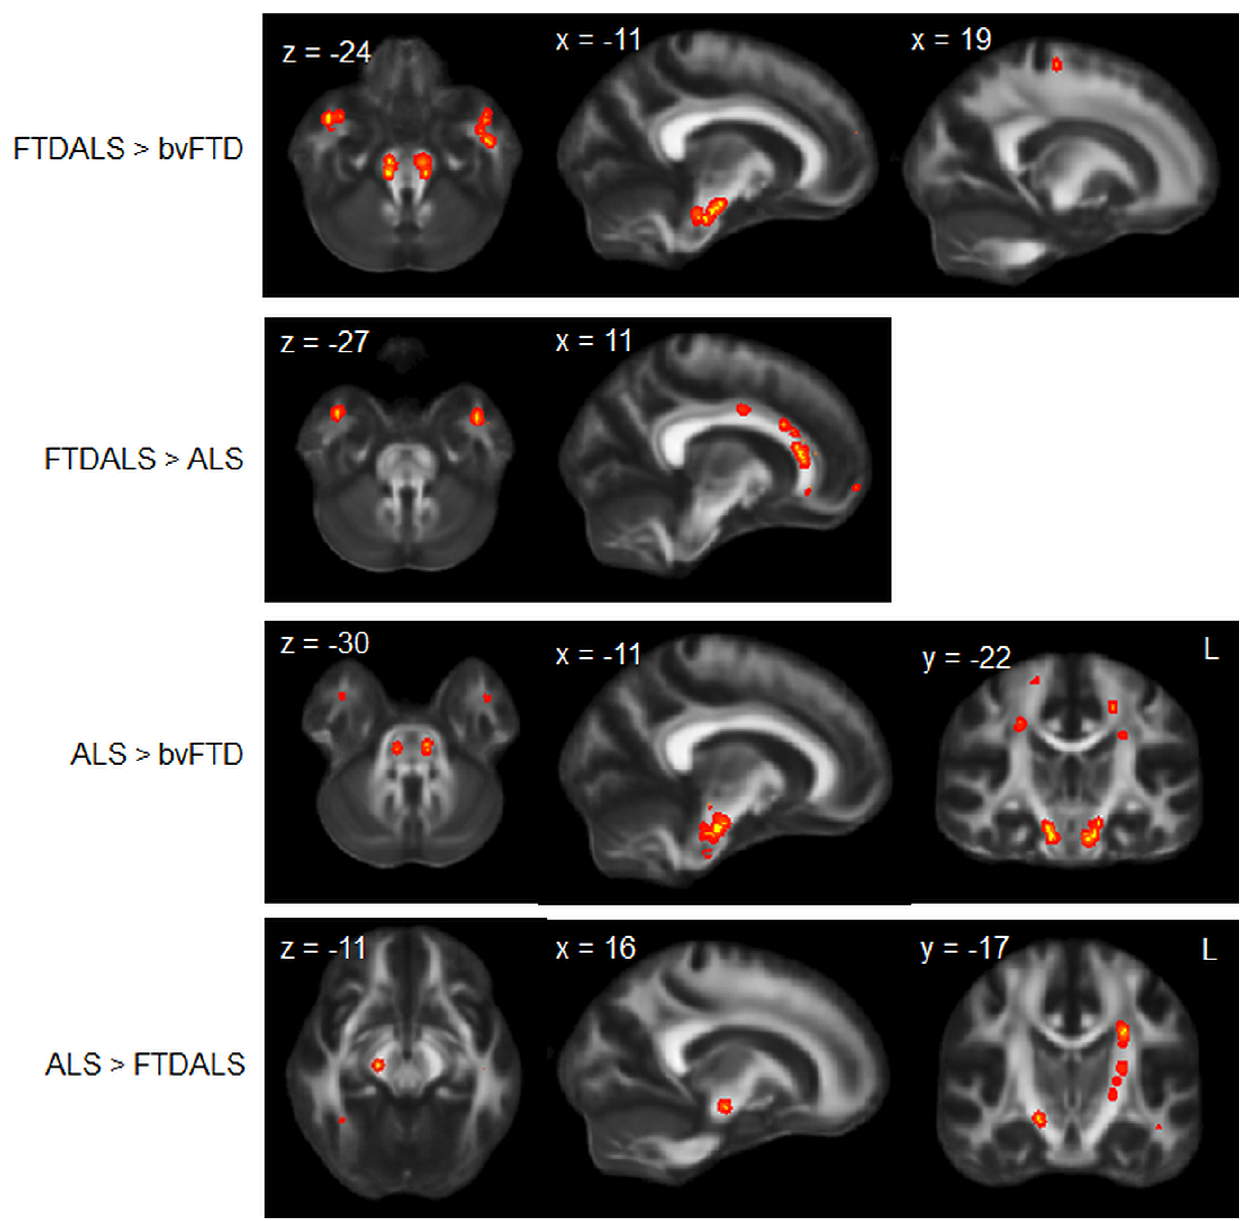
Figure 3. Unique white matter changes across patient groups. Diffusion tensor imaging analysis showing regions of unique white matter changes across groups. Clusters are overlaid on the MNI standard brain (t=2.41). Coloured voxels show regions that were significant in the analyses for p , 0.05 FWE corrected.